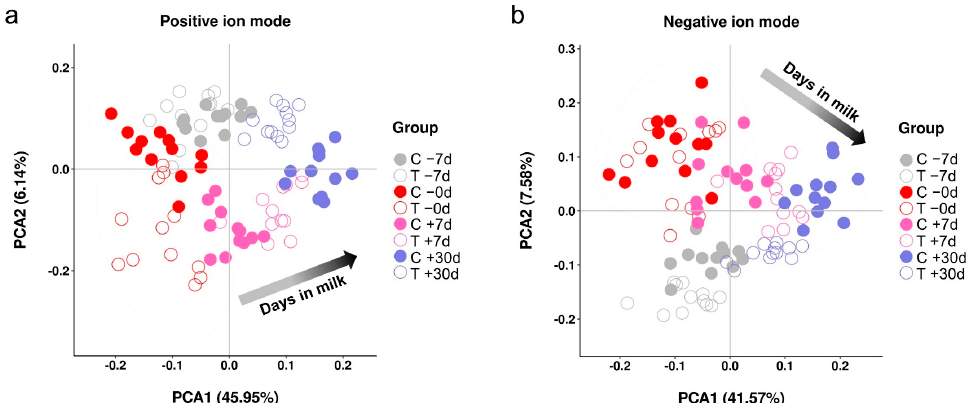
Figure 2. Principal component analysis score plot of the plasma metabolome for the exercise and control groups at − 7 d, 0 d, +7 d, and +30 d relative to calving in the positive-ion mode ( a ) or negative-ion mode ( b ). PC1 represents the first principal component and PC2 represents the second principal component. The black arrow indicates the days in milk of dairy cows during lactation, in which, the light and dark shading represent shorter and longer days in milk,